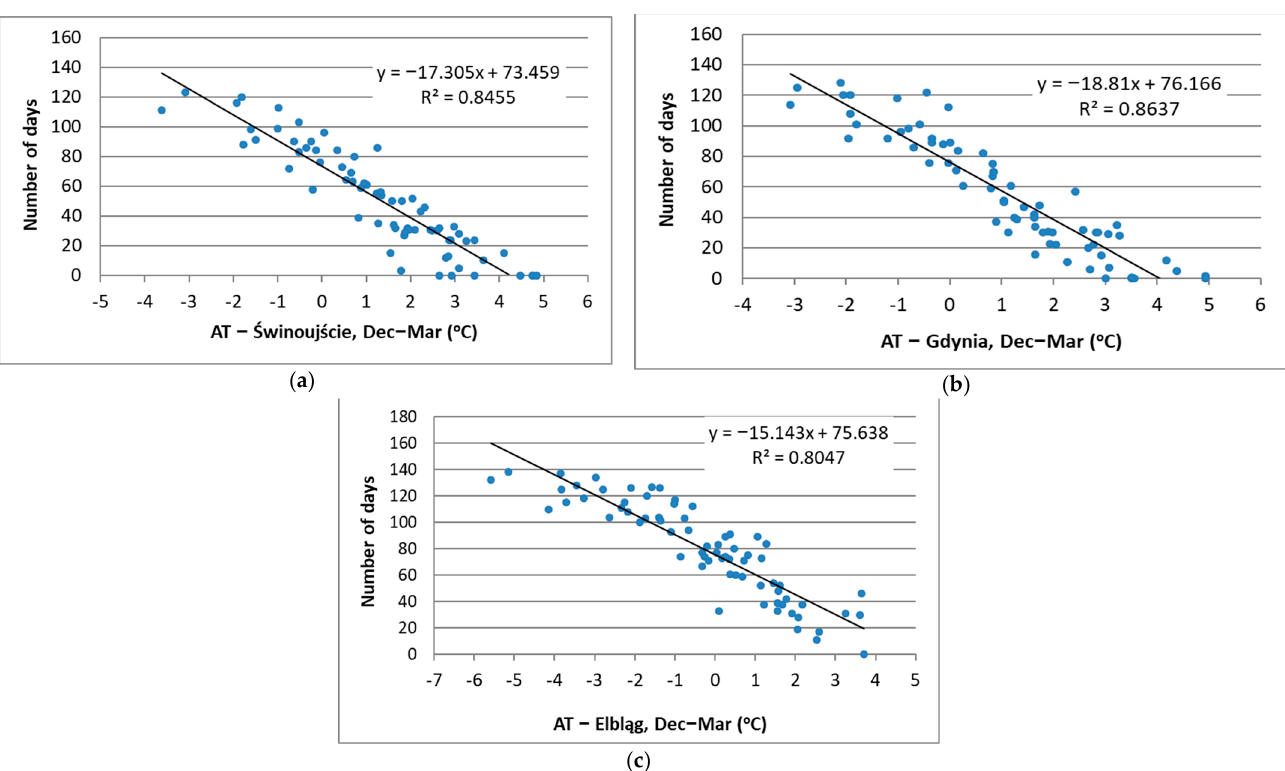
Figure 5. Correlations between the number of days with ice (N) on ( a ) Szczecin Lagoon; ( b ) Puck Lagoon; ( c ) Vistula Lagoon, with winter (Dec–Mar) air temperatures (ATs) through the period 1950/51–2019/20, along with the regression line equation and determination coefficient (R 2 ).